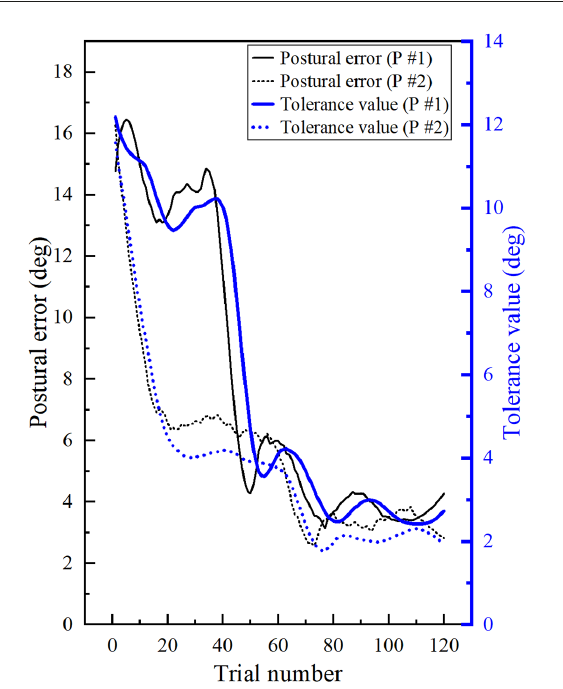
FIGURE5 Postural error and tolerance values for two participants: The left (thin, black) axis represents the postural error, and the right (thick, blue) axis represents the tolerance value. Solid lines represent participant number 1, and dotted lines represent participant number 2. Despite similar postural errors at the end of the training, the postural error trajectory is different for both the participants. Computed tolerance values are adapted to the postural performance of individual